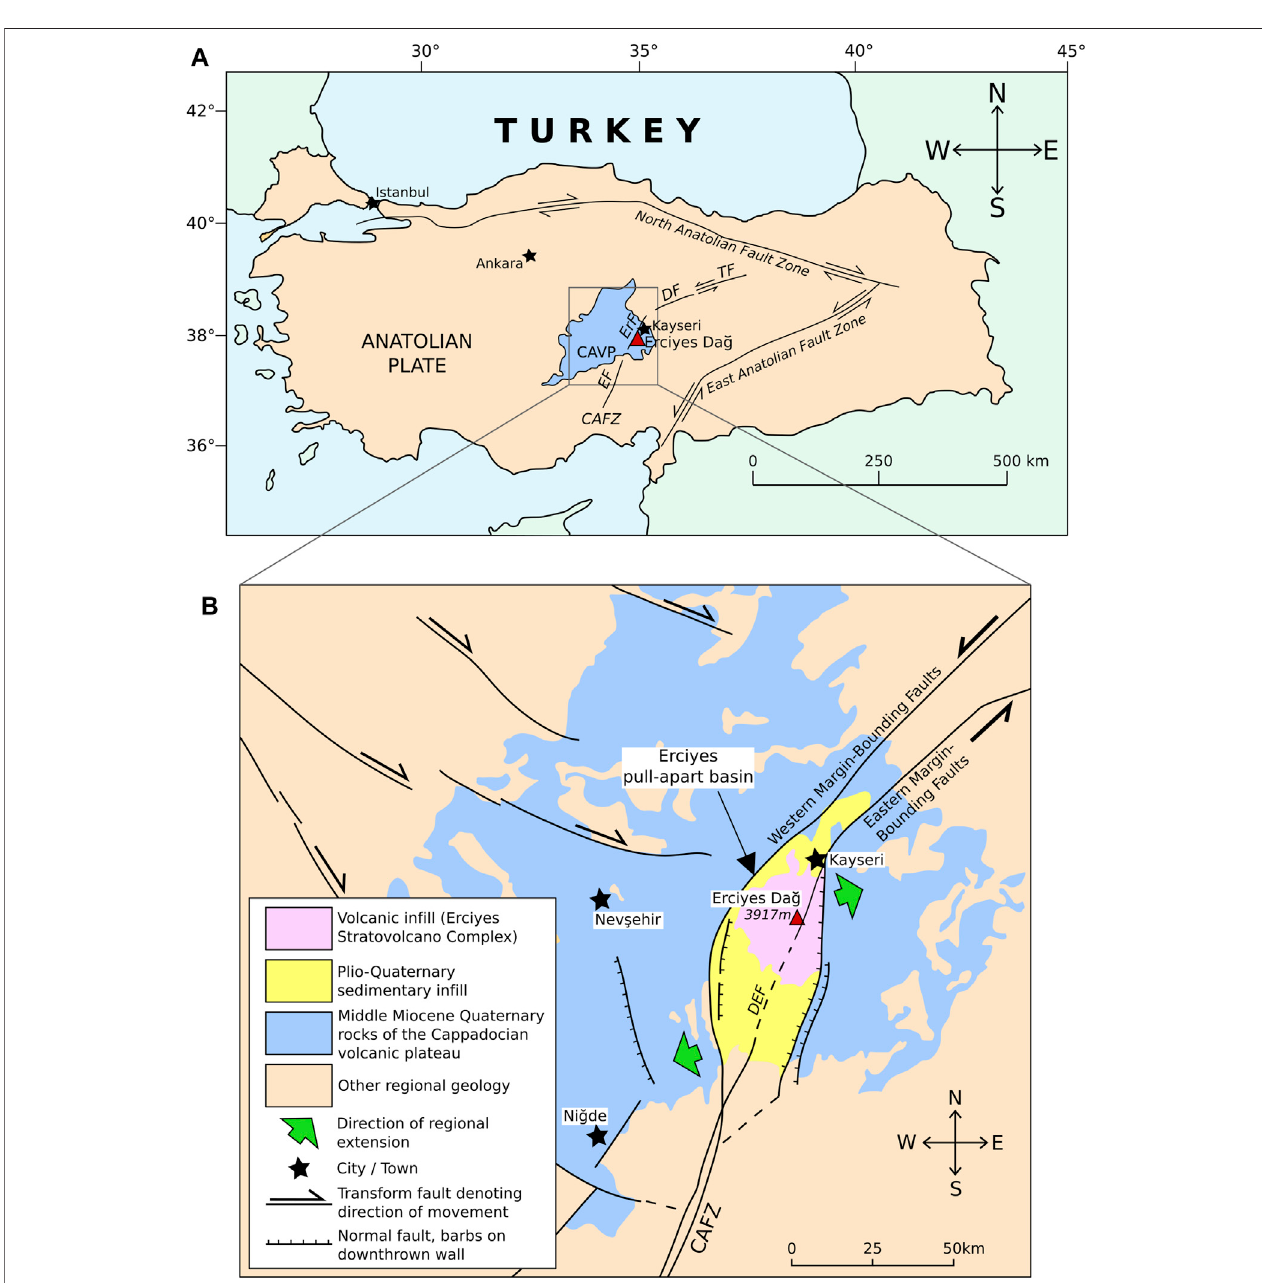
FIGURE 1 | Location of Erciyes Da ğ within the Central Anatolian Volcanic Province (CAVP). (A) Tectonic overview map of Central Anatolia and Turkey after Dogan et al. (2013). The Anatolian plate is bounded by the Northern and Eastern Fault Zones between the colliding Eurasian and Arabian plates. (B) Regional volcano-tectonic map of Erciyes Da ğ after Koçyi ğ it and Erol (2001). The volcano is located 25 km south of the city centre of Kayseri and within the Erciyes pull-apart basin (EPB). Note: CAFZ (cid:1) Central Anatolian Fault Zone, TF (cid:1) Tecer Fault, DF (cid:1) Deliler Fault, ErF (cid:1) Erciyes Fault, EF (cid:1) Ecemis Fault, DEF (cid:1) Dundarli-Erciyes Fault segment.